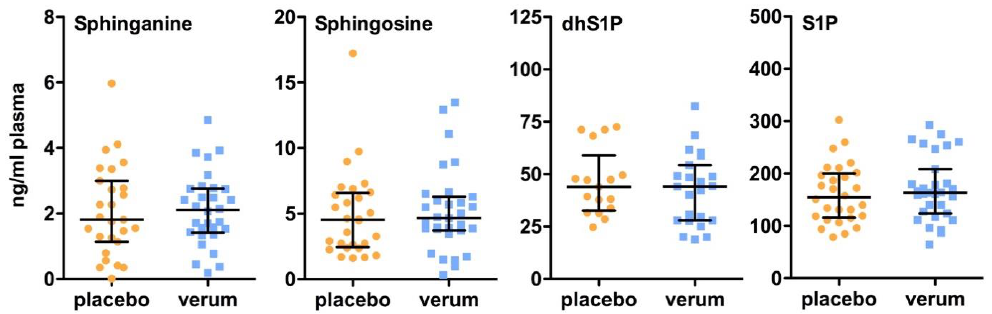
Figure 3. Effect of vitamin D supplementation on plasma sphinganine, sphingosine, and 1-phosphate derivate levels. All patients were treated for 6 months with either a placebo or 1904 IU/d vitamin D. Plasma sphingolipid concentrations were measured by LC-MS/MS. Dates are shown as median ± IQR (Mann Whitney U test). Abbreviations: dhS1P, sphinganin 1-phosphate; S1P, sphingosine 1-phosphate.